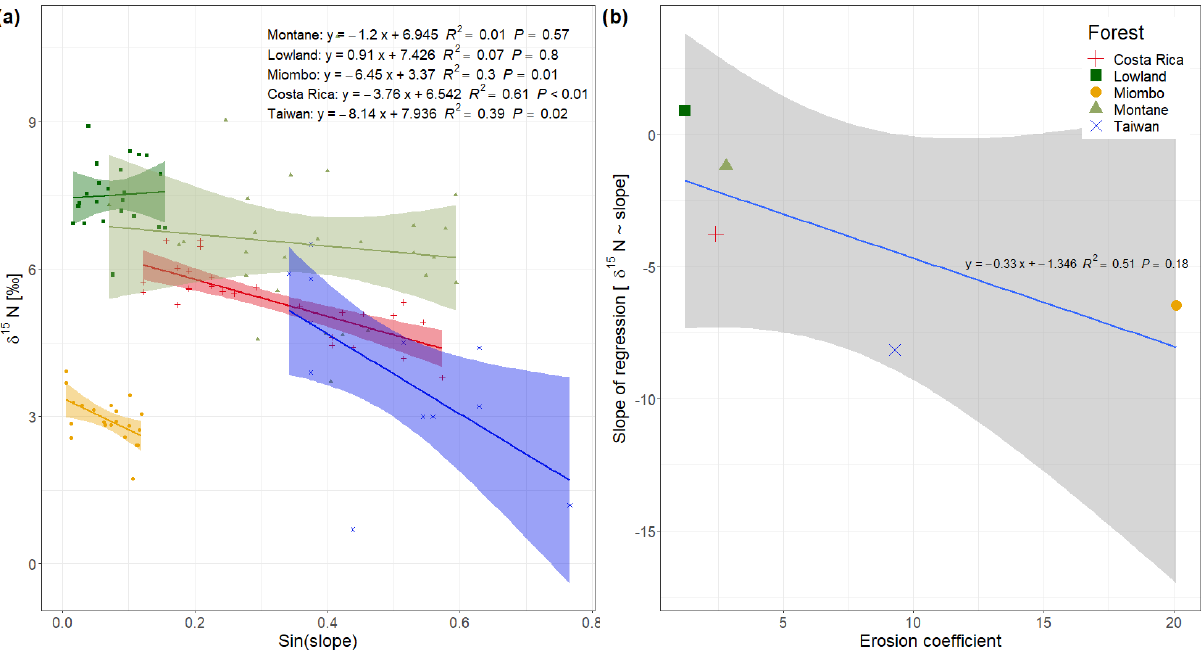
Figure 3. (a) Soil δ 15 N values vs. sinus of the slope from the spatial sampling of topsoil (0–20cm) in DRC, including data from Costa Rica (Weintraub et al., 2015) and Taiwan (Hilton et al., 2013); (b) slope of the regressions from (a) plotted against the mean erosion coefficient (Eq. 2) of each study